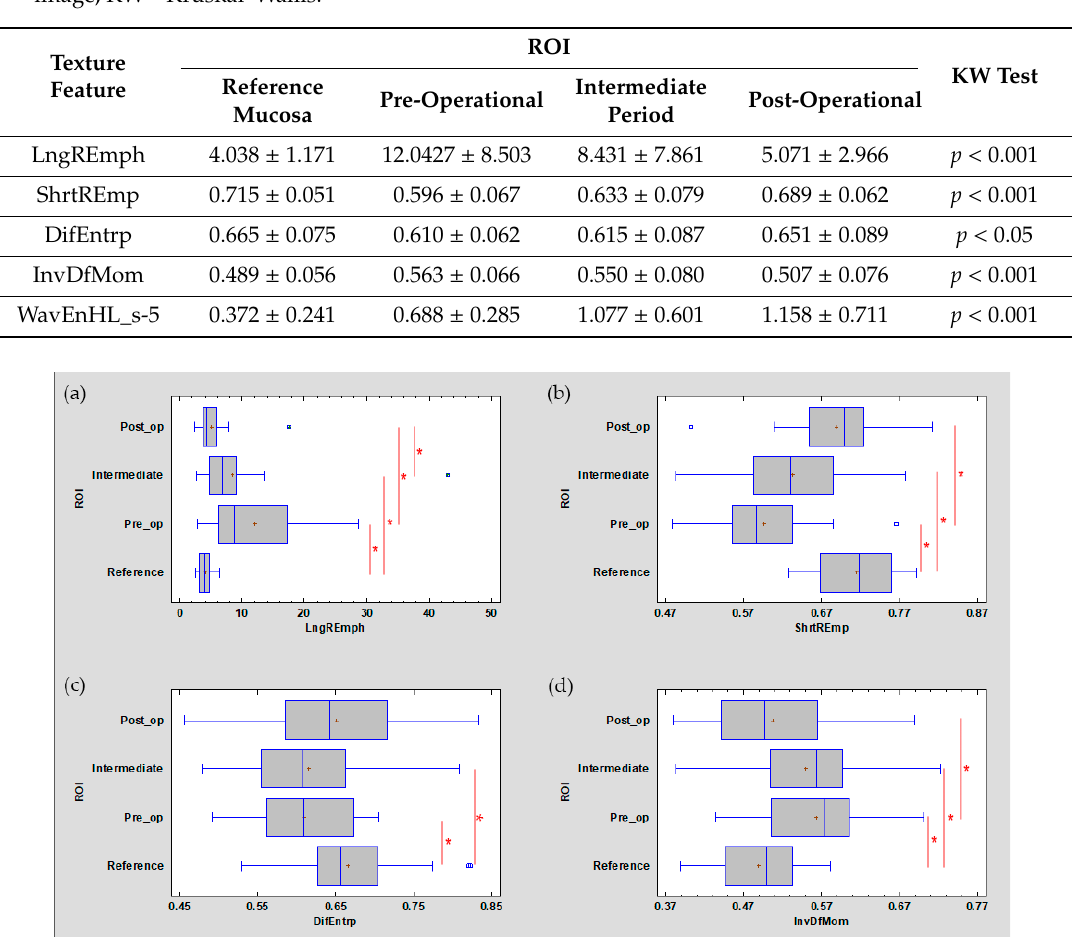
Table 1. Digital texture analysis of oral mucosa photographic images after leukoplakia treatment by Er:YAG laser (average ± standard deviations). Abbreviations: ROI—region of interest, i.e., sample of image, KW—Kruskal–Wallis.